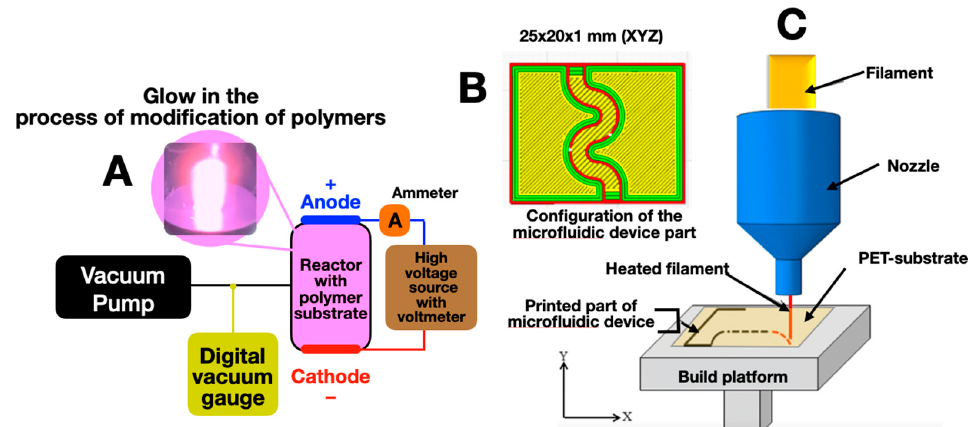
Figure 1. Schematic of a plasma-chemical plant for PET modification ( A ); configuration of microfluidic elements [68] ( B ); and schematic diagram of 3D printing by (FFF) ( C ) [69].